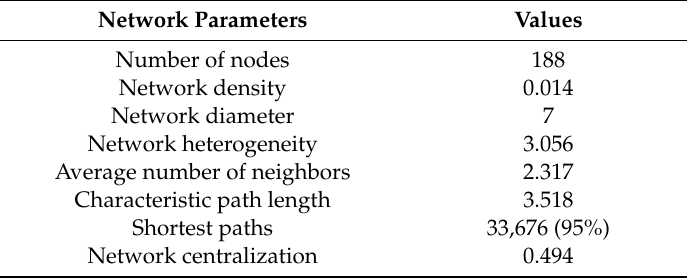
Figure 1. HDW compound–target network. Green represents the HDW compounds and yellow represents the targets of the HDW compounds. Table 2. HDW compound–candidate target network